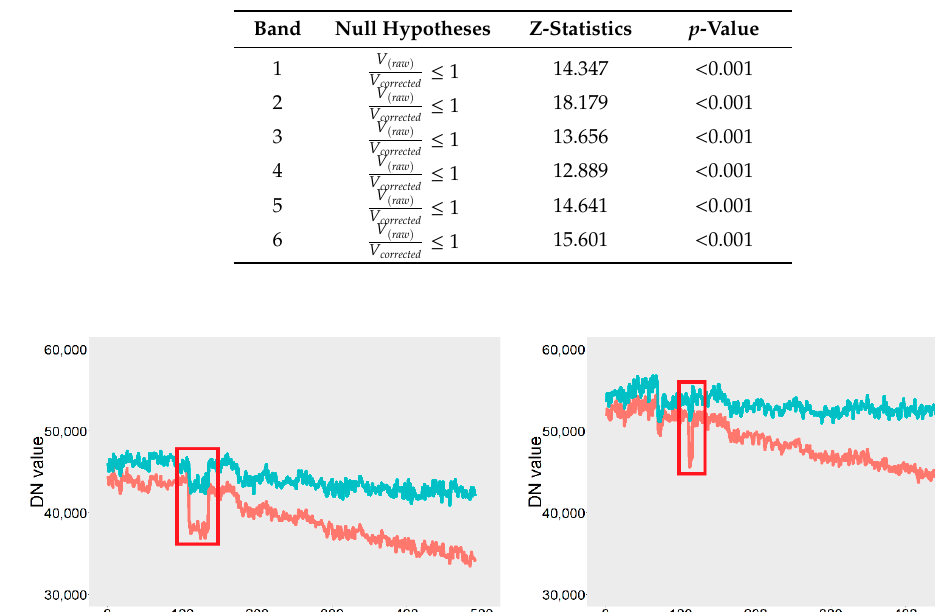
Table 5. The results of Fligner-Killeen scale test. V means variation of samples extracted from original raw image and fully corrected image.